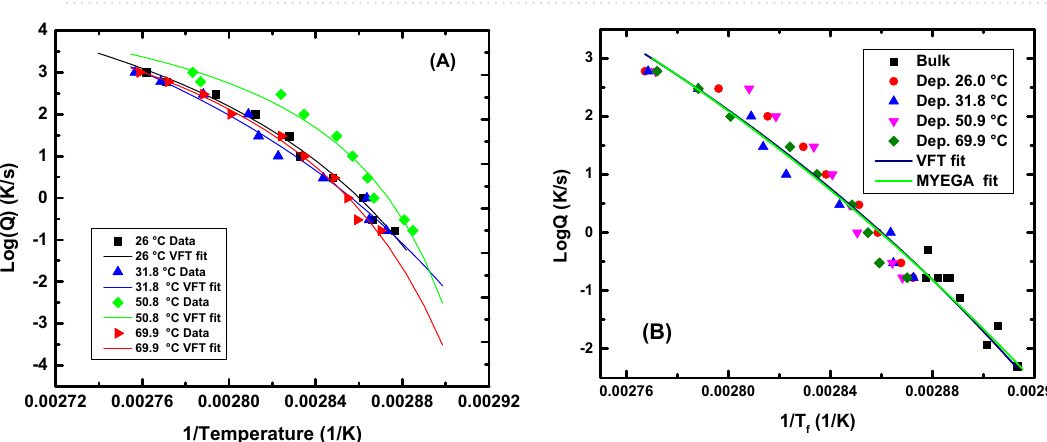
Figure 5. Cooling rate dependence of T f for VPD and bulk CYTOP. ( A ) Cooling rate dependence of rejuvenated VPD CYTOP films along with their VFT fits. ( B ) All CRD data for the VPD CYTOP films and the virgin material CRD data along with the VFT and MYEGA fits on the data. Here, data for the deposition temperature of 50.9 °C have been shifted by + 3 °C and the virgin (bulk) material fictive temperatures has been shifted by -29 °C. VFT parameters for individual data sets are presented in Section 2 of the Supplemental Information